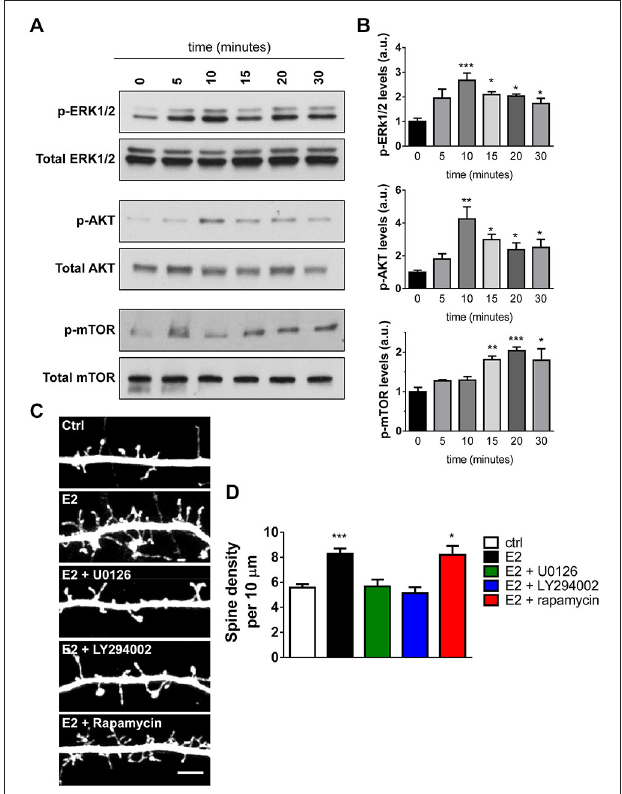
FIGURE 3 | Activation and requirement of specific kinase pathways during E2-mediated spinogenesis. (A) Western Blot analysis of ERK1/2, Akt, and mTOR pathways in cell lysates of neurons treated with E2 for increasing amounts of time. Membranes were incubated with phospho-specific antibodies followed by incubation with antibodies against total protein. (B) Quantification of the temporal activation of kinase pathways following E2 treatment; all time points were compared to 0 min (untreated) ( ∗ p < 0.05; ∗∗ p < 0.01; ∗∗∗ p < 0.001; n = 4 independent experiments). (C) Representative confocal images of dendritic spines on secondary dendrites from DIV 25 eGFP expressing primary cortical neurons. Neurons were pretreated (30 min) with vehicle (ctrl) or MEK/ERK1/2 inhibitor U0126, PI3-K/Akt inhibitor LY294002, or mTOR inhibitor rapamycin followed by treatment with vehicle or E2 for an additional 30 min. (D) Quantification of linear spine density from cells in (C) . Pretreatment with U0126 or LY294002 but not rapamycin blocked E2-mediated spinogenesis ( ∗ p < 0.05; ∗∗∗ p < 0.001; n = 12–16 cells per condition). Scale bar = 5 µ m.